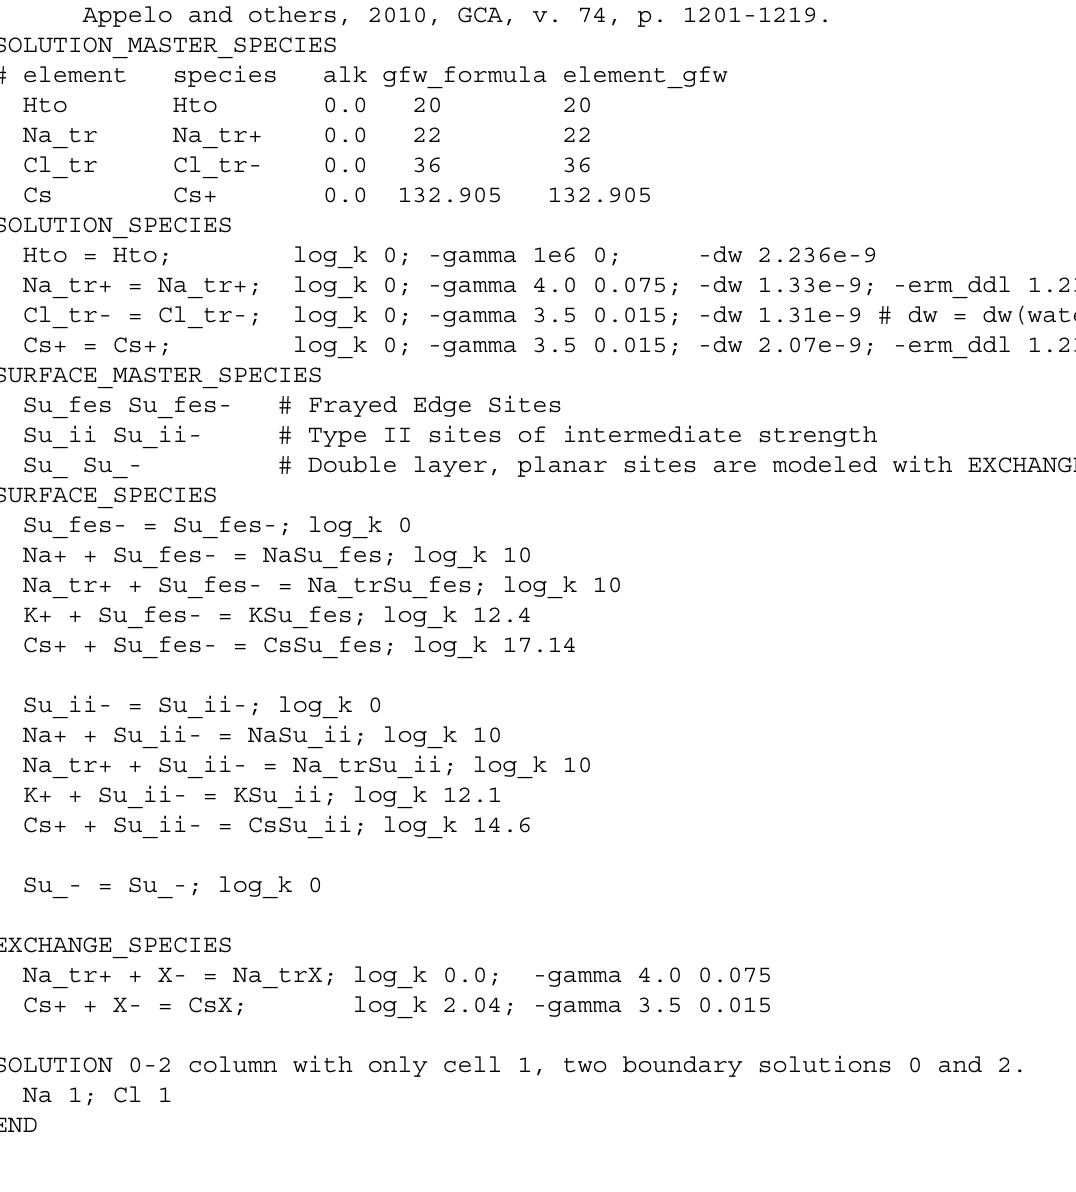
Table 60. Input file for example 21. TITLE Diffusion through Opalinus Clay in a radial diffusion